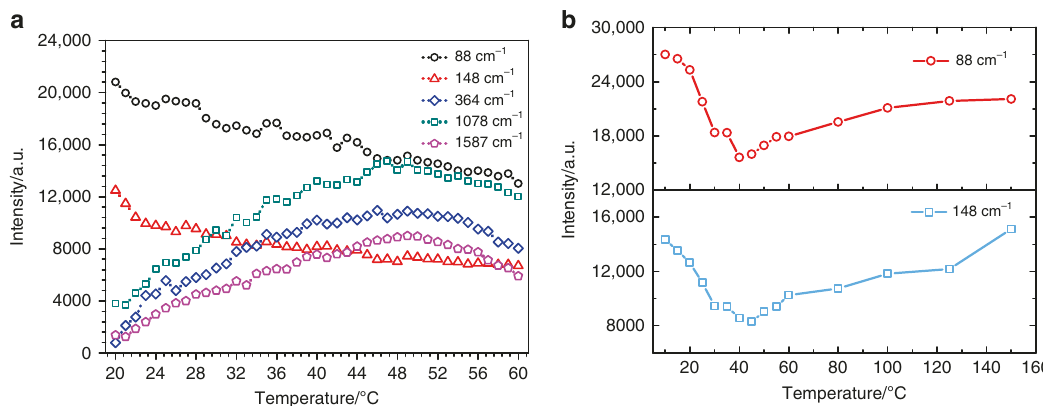
Fig. 4 Temperature effect. a Temperature-dependent SERS peak intensities of the 4MBA/Ag/Ag-doped TiO 2 hybrid system. b Temperature-dependent of Raman peak intensities of the Ag/Ag-doped TiO